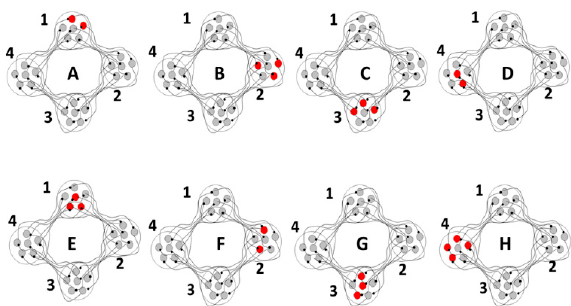
Figure 21. Schematic representation of the basic architecture of the computer simulations. Represented is one oscillator to show the structure of neurons within each node and how information is transmitted via subsets of neurons within each node. A four-node oscillator (nodes 1–4) whose nodes contain five neurons each is illustrated. A series of time intervals (A–H) are represented. Neurons become active in node 1 at time A. The activity then propagates to neurons in subsequent nodes. For any part of the cycle, a subset of neurons in each node becomes active and the specific neurons that are active vary with each cycle. Thus the neurons active at time B in node 2 are different than the neurons active in node 2 at time F. Multiple oscillators of different numbers of nodes, thus different inherent fundamental frequencies, can be linked [1].